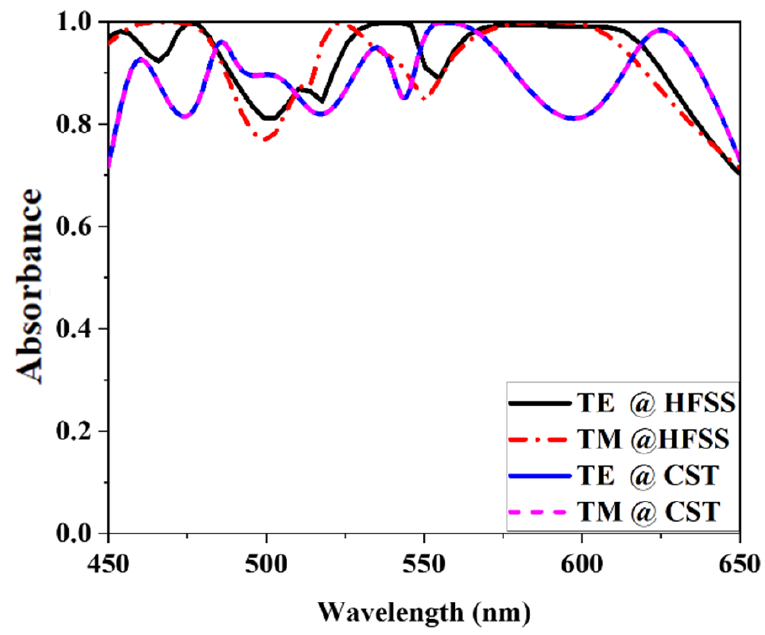
Figure 16. The proposed MMA absorbance comparison with different simulation software.